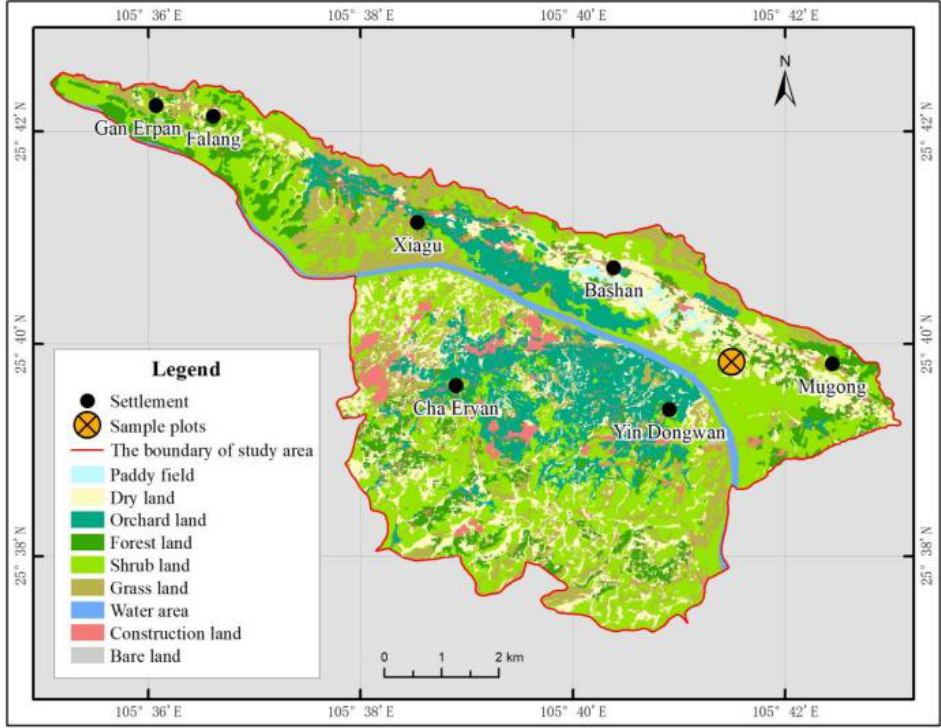
Figure 1. Schematic diagram of the study sample area.